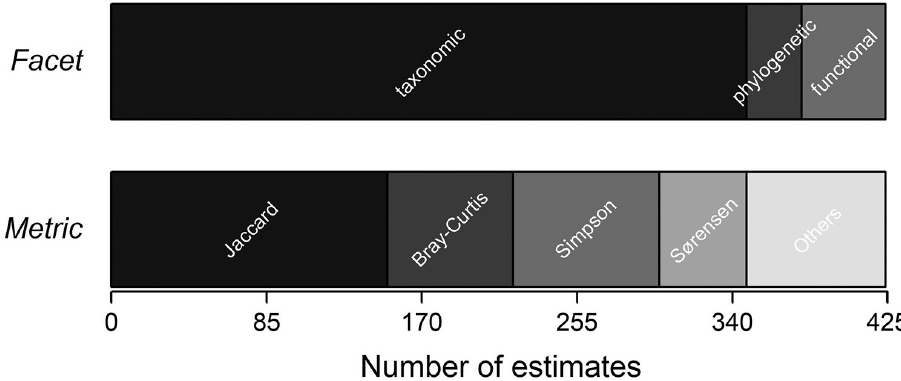
Figure 4. Methodological focus of the biotic homogenisation articles assessed. The facets include taxo- nomic for species-level analyses; phylogenetic for phylogenetic diversity metrics according to phylogenetic trees or higher taxonomic ranks; and functional according to species-level traits. Biotic homogenisation has been quantified according to presence-absence of species, traits or nodes in the phylogenetic tree (Jaccard, Simpson and Sørensen) or species/trait abundances (Bray-Curtis). Other metrics include the Raup-Crick measure of beta diversity, Morisita-Horn, Euclidean and Gower dissimilarity index and additive and mul- tiplicative definitions of beta-diversity (e.g. β , Whittaker’s β , β Add W Shannon